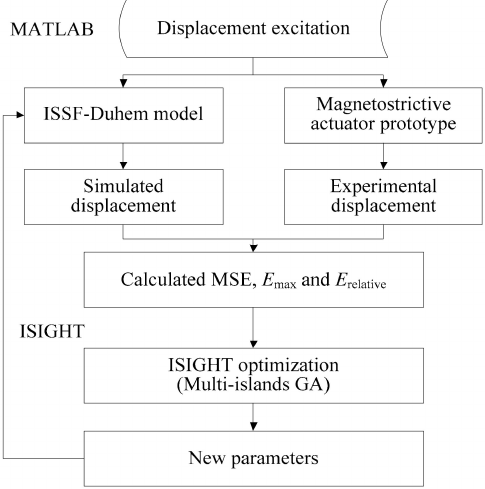
Figure 7. The process of parameter identification for the